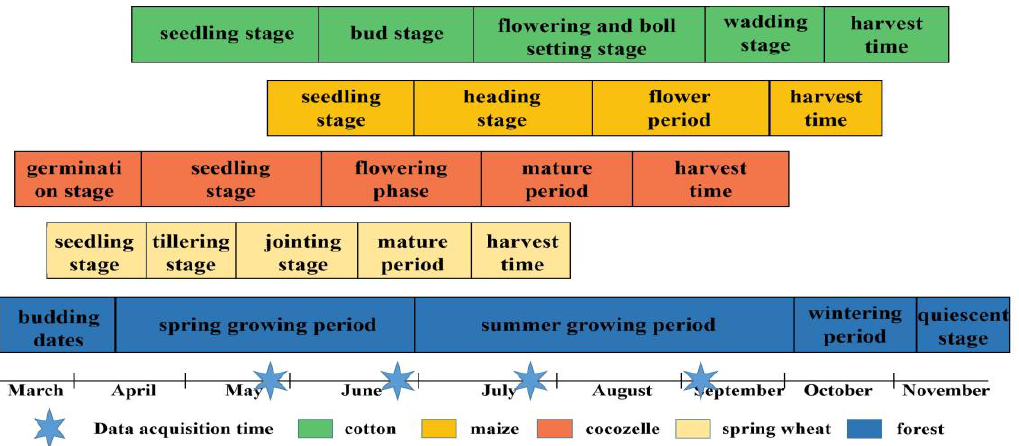
Figure 2. Phenological calendar information of cotton, maize, cocozelle and spring wheat in the study area.